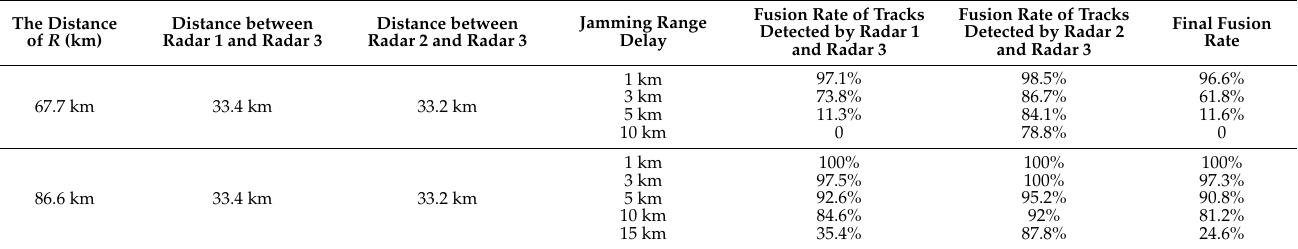
Table 6. Jamming performance evaluation results of ground-based radar network (three